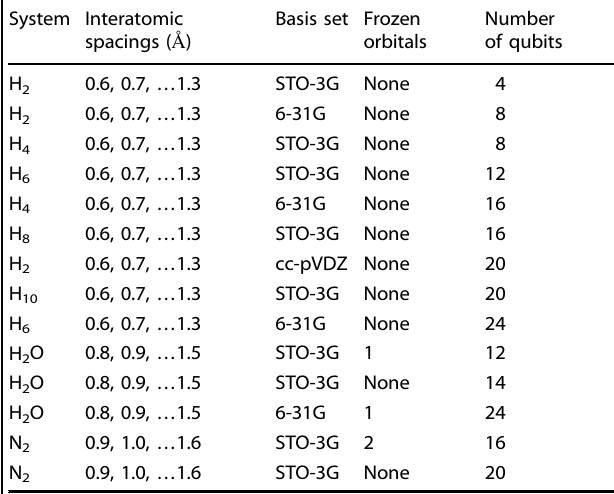
The hydrogen systems consist of a chain of atoms arranged in a line, with equal interatomic spacing. The interatomic spacing for the water molecules refers to the length of the symmetrically stretched bonds O – H bonds, which are separated by a fi xed angle of 104.5°. The active space used for each system has one spatial orbital for every two qubits. A nonzero number of frozen orbitals indicates the number of molecular orbitals fi xed in a totally occupied state.